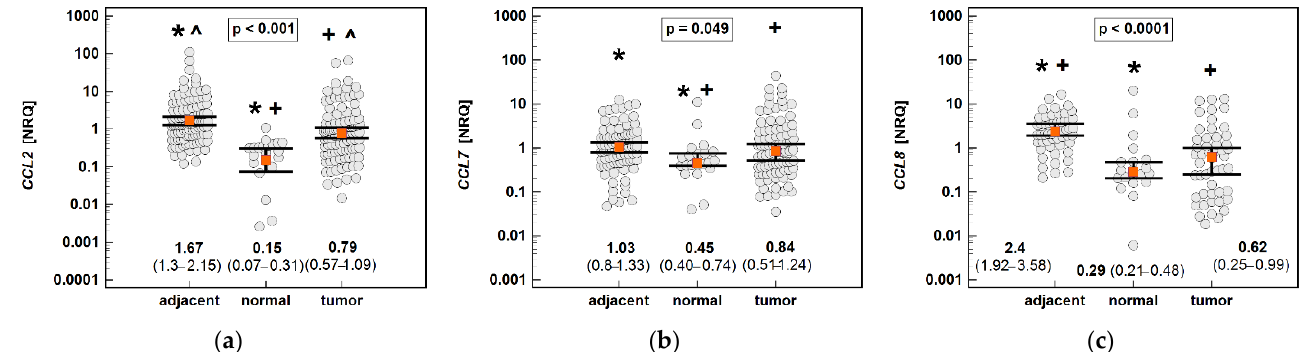
Figure 14. An expression of MCP chemokines in tumor and tumor-adjacent tissue compared to normal mucosa from non-cancer patients: ( a ) CCL2 ; ( b ) CCL7 ; ( c ) CCL8 . The data are presented as means ( CCL2 ) or medians ( CCL7 and CCL8 ) with 95% confidence intervals. The data were analyzed using one-way ANOVA with a Student-Newman-Keuls post hoc test or a Kruskal – Wallis H test with a Conover post hoc test, respectively. The significant between-group differences are indicated by the same type of symbol: *, +, or ^. NRQ, normalized relative quantities.